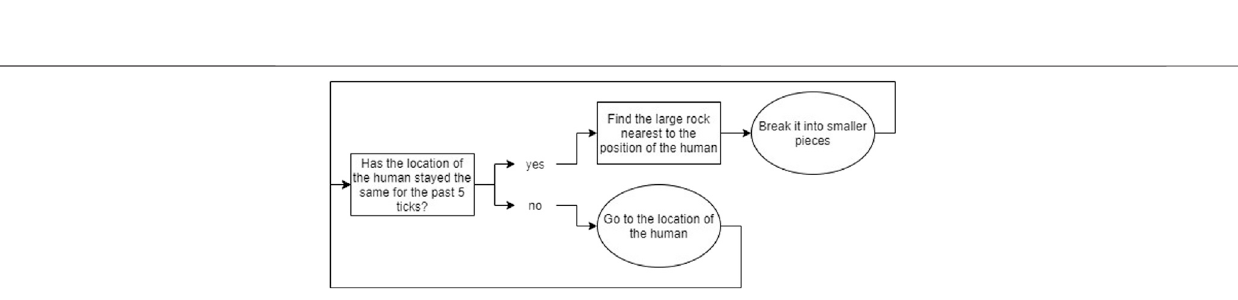
FIGURE 5 | A fl owchart showing the rule-based decision making the agent would go through when using Macro-Action 3.